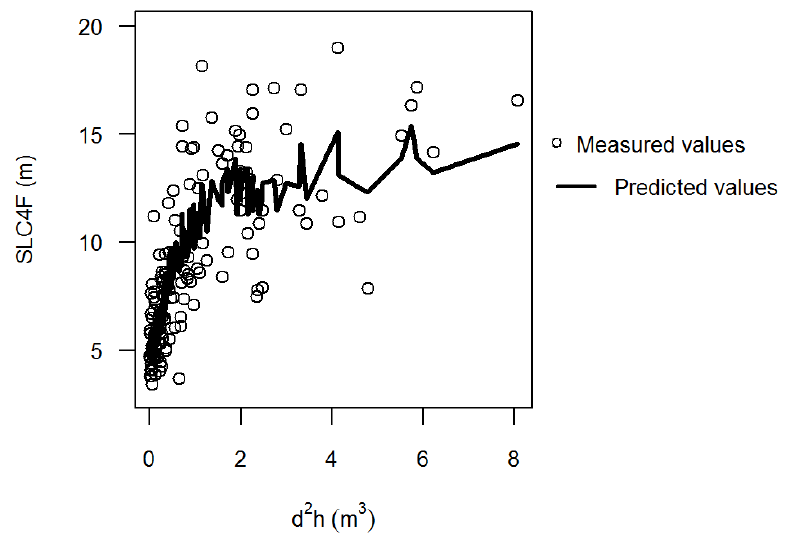
Figure 5. Measured against predicted values from Equation (8) highlighting the important effect of the volume of the tree ( d 2 h ) on the longest clearbole section on each of the four faces ( SLC4F ) of the stem.